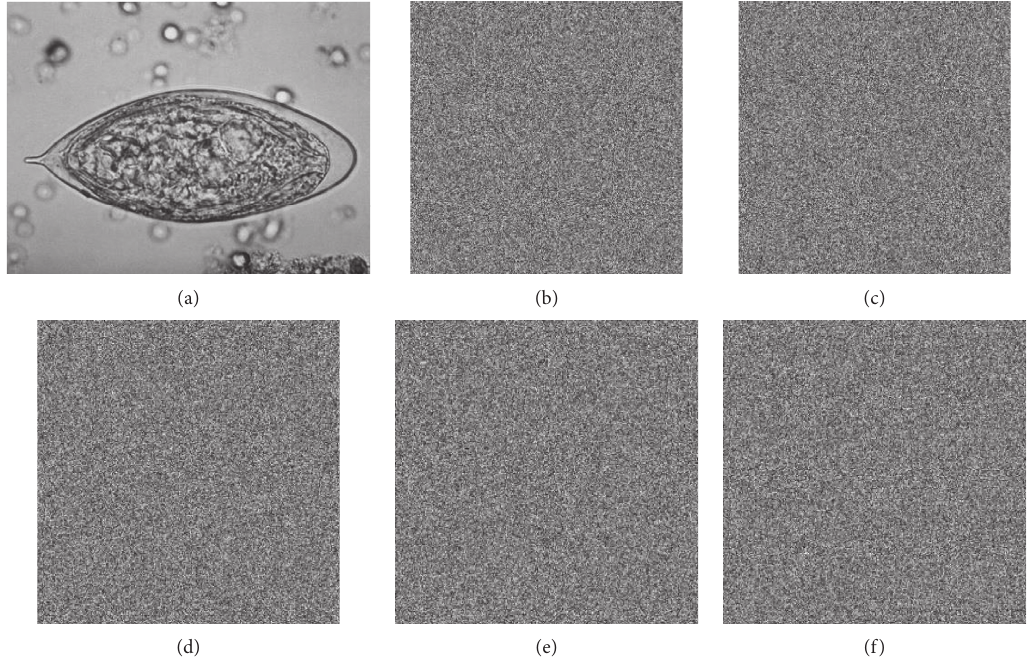
Figure 7: Plain and cipher images. (a) The plain image of «S-Hematobium egg». (b) to (f) The different cipher images obtained with different external